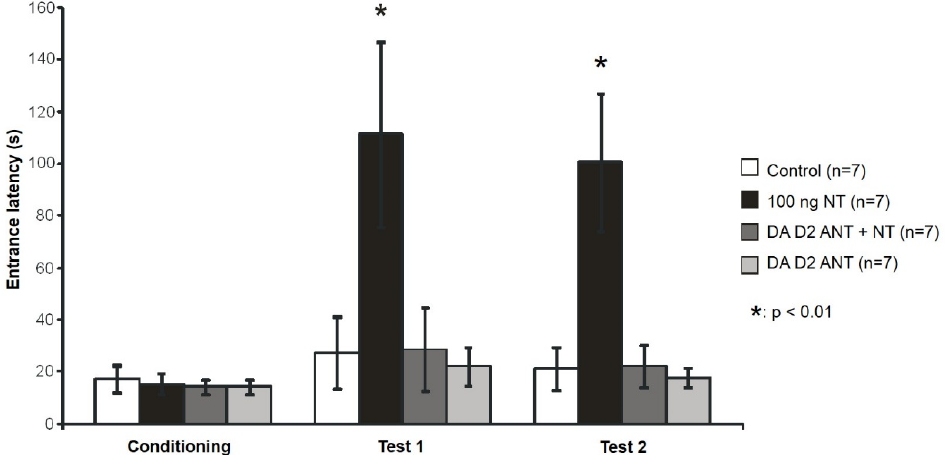
Figure 3. Effect of DA D2 antagonist sulpiride in passive avoidance test. Entrance latencies during conditioning, test 1 (24 h after conditioning) and test 2 trials (1 week after conditioning) are shown (+/− SEM). Control: vehicle-treated rats (n = 7); 100 ng NT: animals microinjected with 100 ng NT (n = 7); D2 ANT + NT: animals microinjected with 100 ng NT pretreated with 5 µg sulpiride (n = 7); D2 ANT: rats treated with 5 µg sulpiride (n = 7). * p < 0.01; for more explanation, see the text.